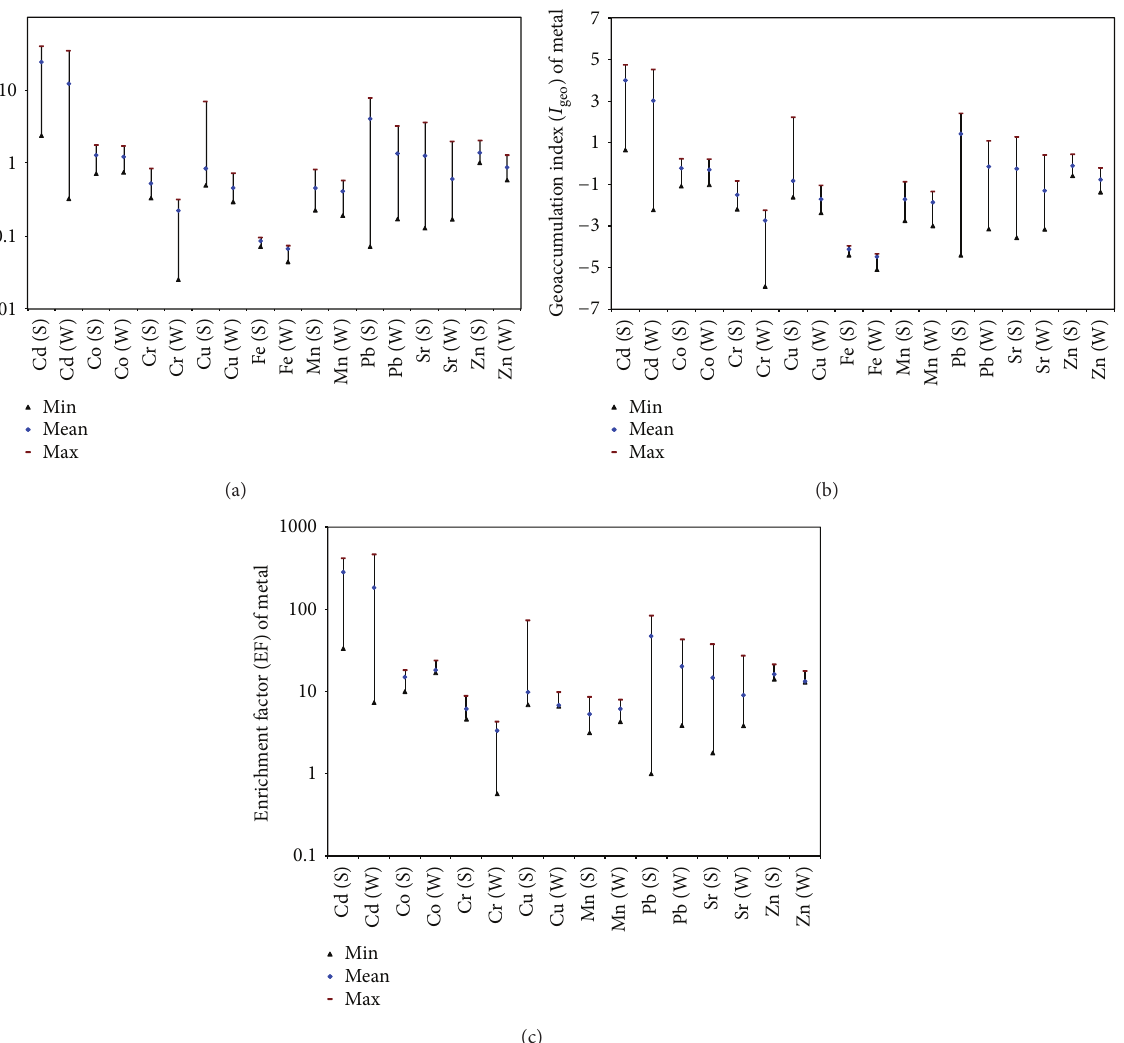
Figure 2: Description of contamination factor (CF), geoaccumulation index ( 𝐼 winter